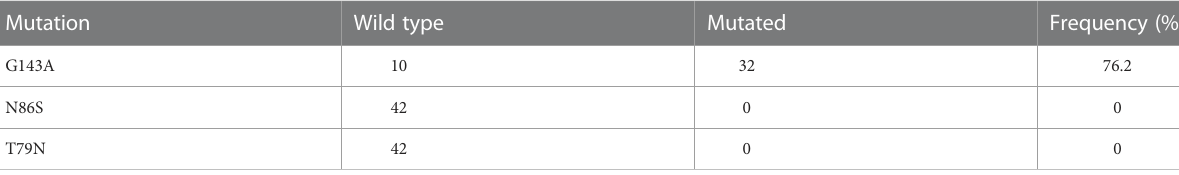
TABLE 3 Frequency of mutations conferring resistance to QoI and SDHI fungicides in Lithuania in 2021.